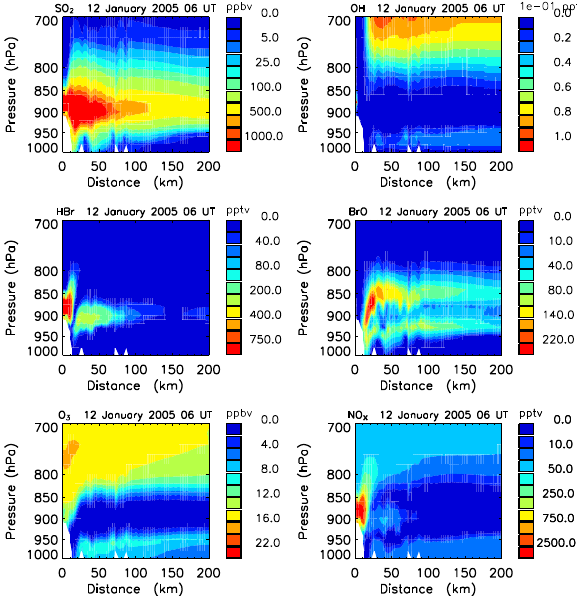
Figure 8. Distance–pressure cross section of the SO 2 , OH, HBr, BrO, O 3 and NO x mixing ratios in the plume of Ambrym on 12 Jan- uary 2005 at 06:00UTC in the simulation